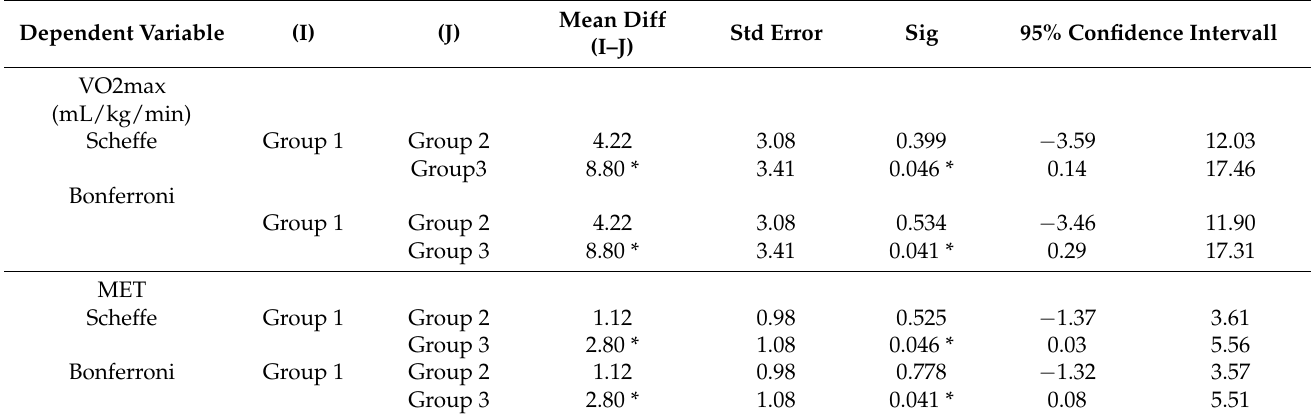
Table 3. Significant results of Bonferroni and Scheffe